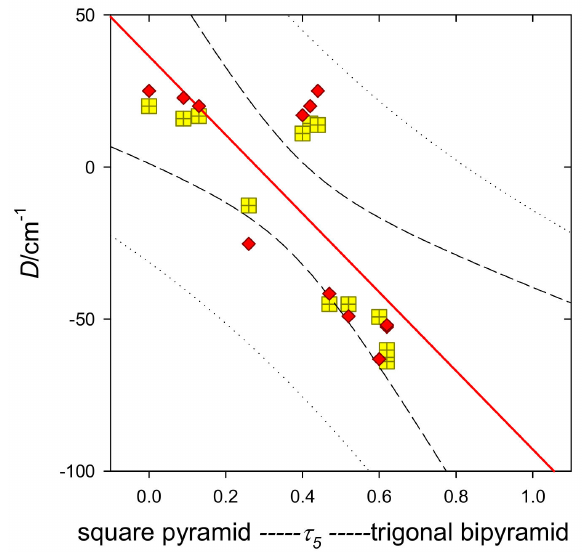
Figure 8. Dependence of the D parameter in pentacoordinate Ni(II) complexes on the distortion pa- rameter ( τ 5 ). Yellow squares—magnetometric data; red pica— ab initio calculations; solid—correlation line, dashed—confidence intervals, dotted—prediction